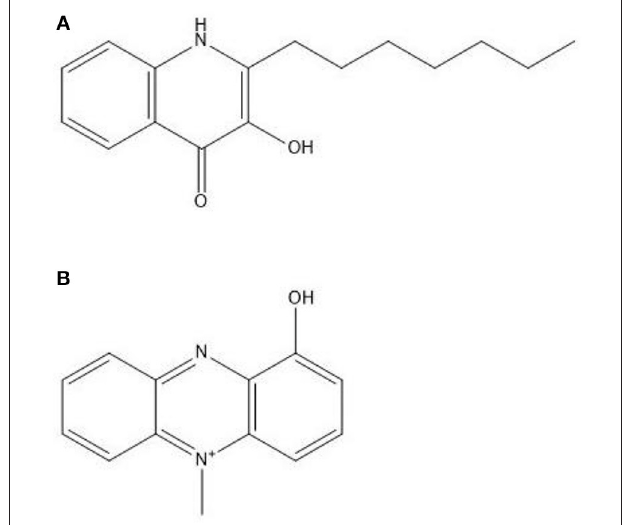
FIGURE 3 | Structures of (A) Pseudomonas quinolone signal at the top and (B) pyocyanin underneath.